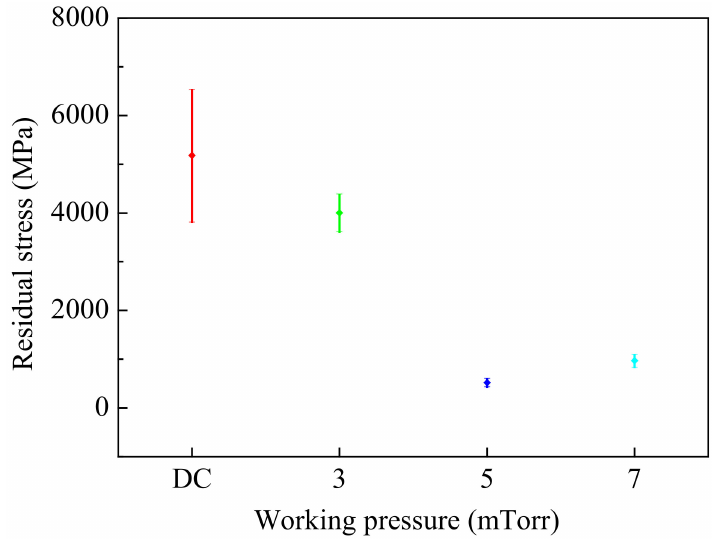
Figure 6. Applied XRD to analyze the residual stress resulting from different working